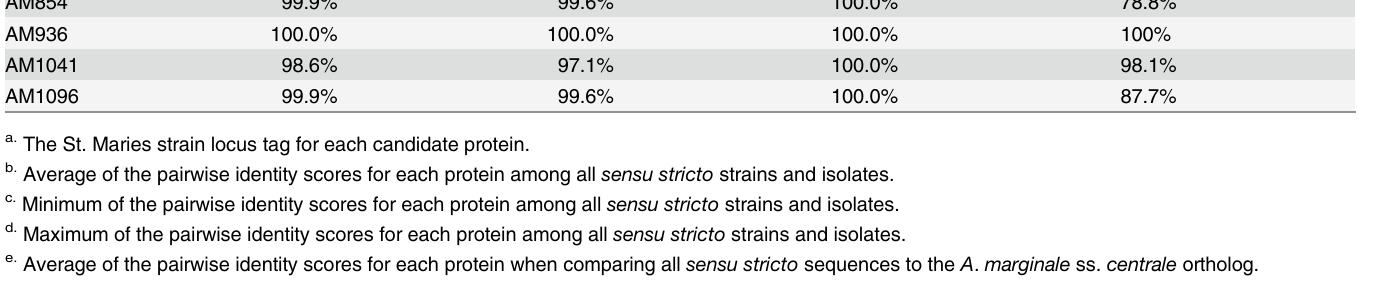
median titers of < 100 (Table 2). The mean titers for both AM854 and AM936 were statistically significantly greater (p = 0.02) as compared to titers to AM202 and AM1096. There was no sta- tistically significant difference between mean titers to AM854 and AM936 (p = 0.93). Conse- quently both AM854 and AM936 were selected for testing by immunization and challenge.